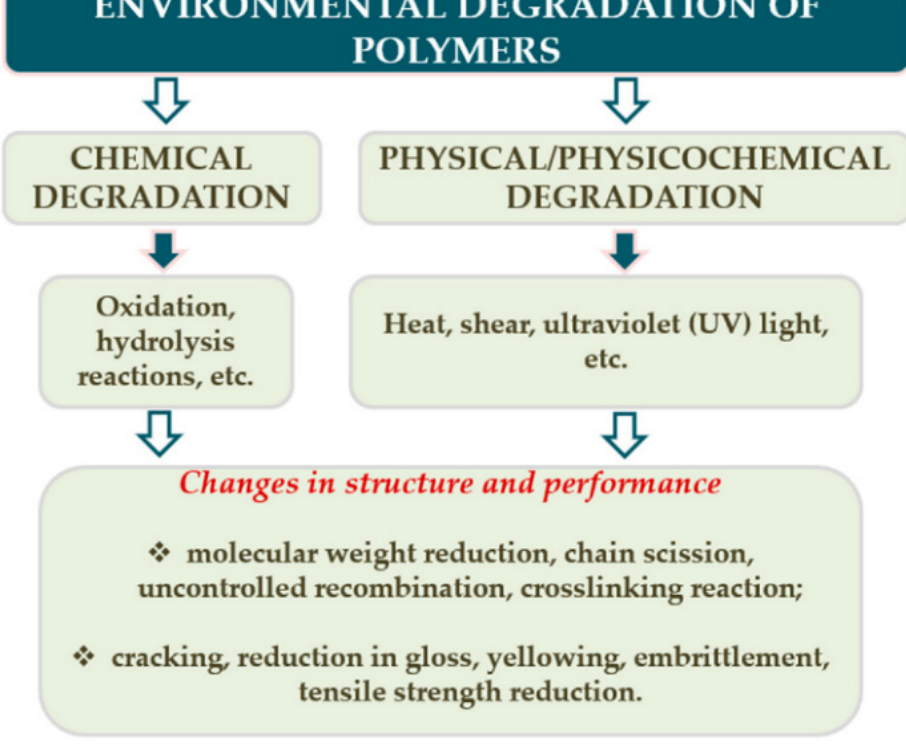
Figure 2. Schematic representation of the environmental degradation of polymers: chemical and physicochemical degradation factors [16].